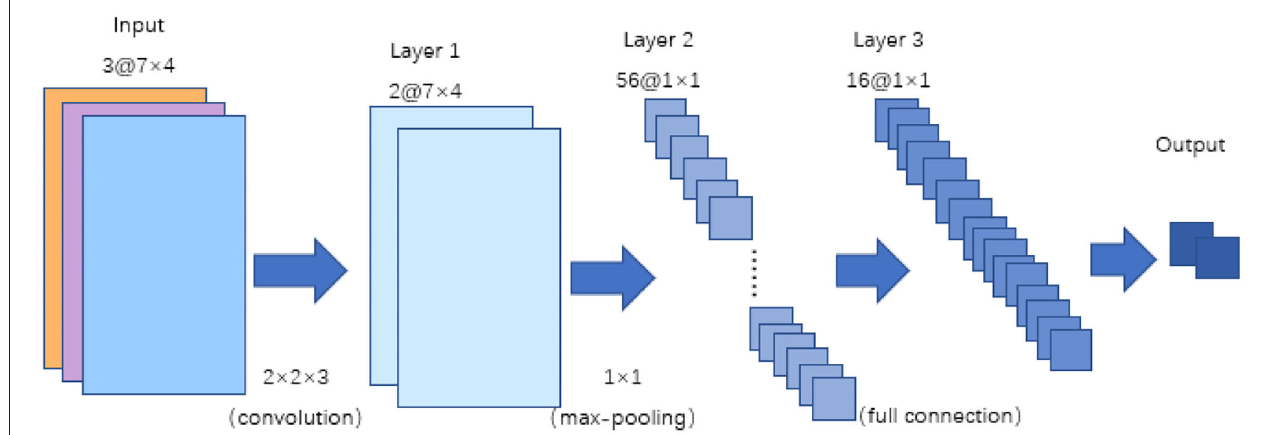
FIGURE 5 | Structure of the